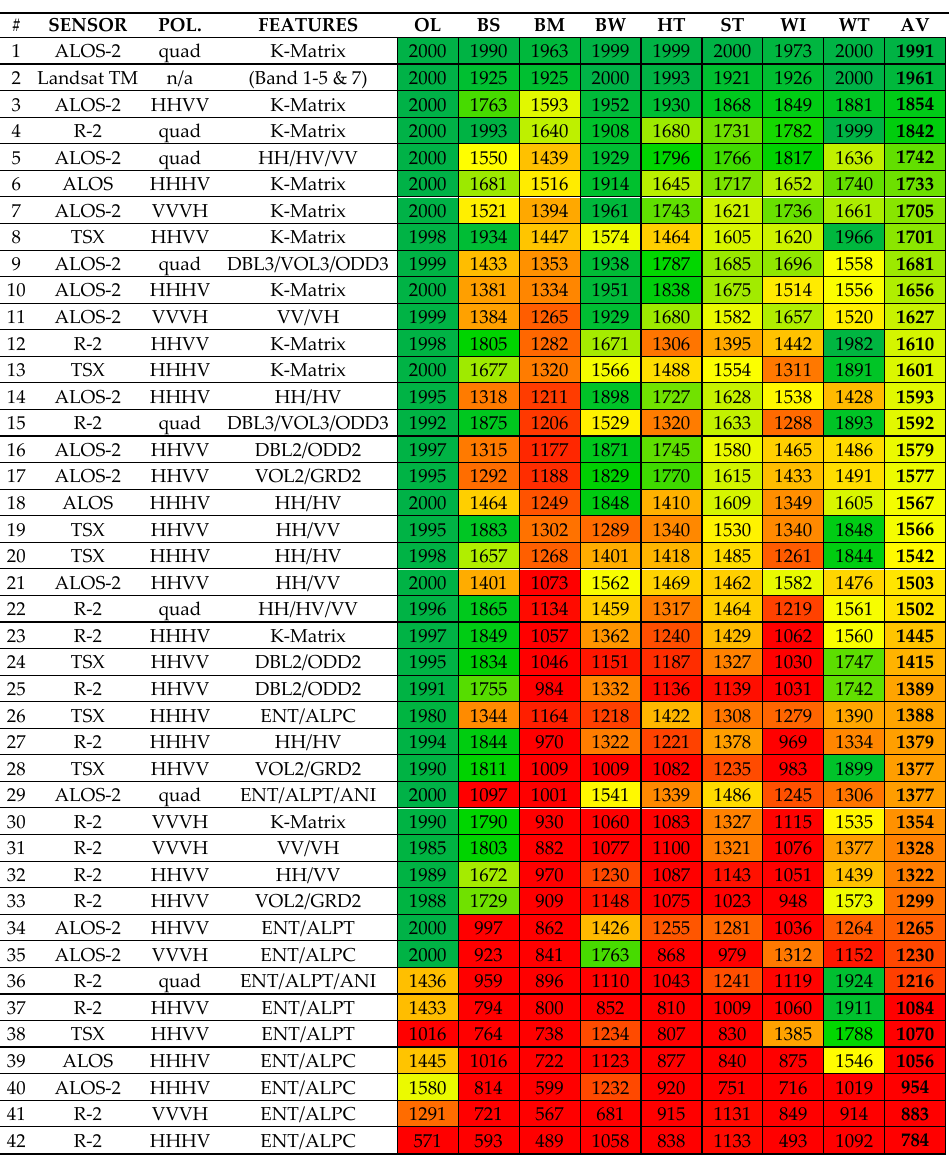
Table 4. Average class separability measured as Transformed Divergence (TD) for classes OL (Permanent Water Bodies), BS (Sand), BM (Mixed Sediment), BW (Driftwood Accumulation), HT (Herb Dominated Tundra), ST (Shrub Dominated Tundra), WI (Inundated Low Lying Tundra) and WT (Wetland) (see Table 2). TD is ranging from 0 to 2000; higher values indicate better class separation. The feature spaces are ranked in descending order of the average separability (AV). The black bars are scaled linearly between the minimum and maximum of AV. The colors from red to yellow to green correspond to the 10%, 50% and 90% quantiles of the AV.